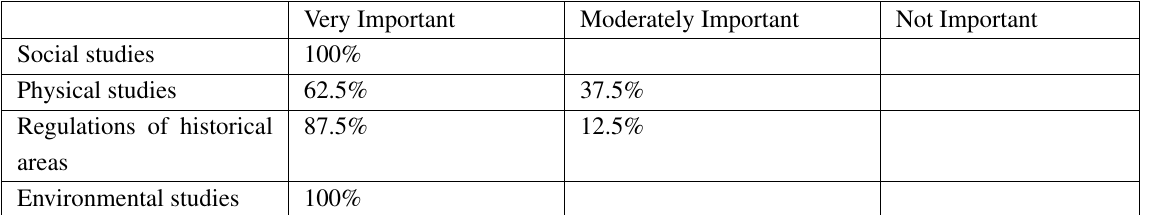
Table 1. From your point of view, which of the following studies helped you improve your